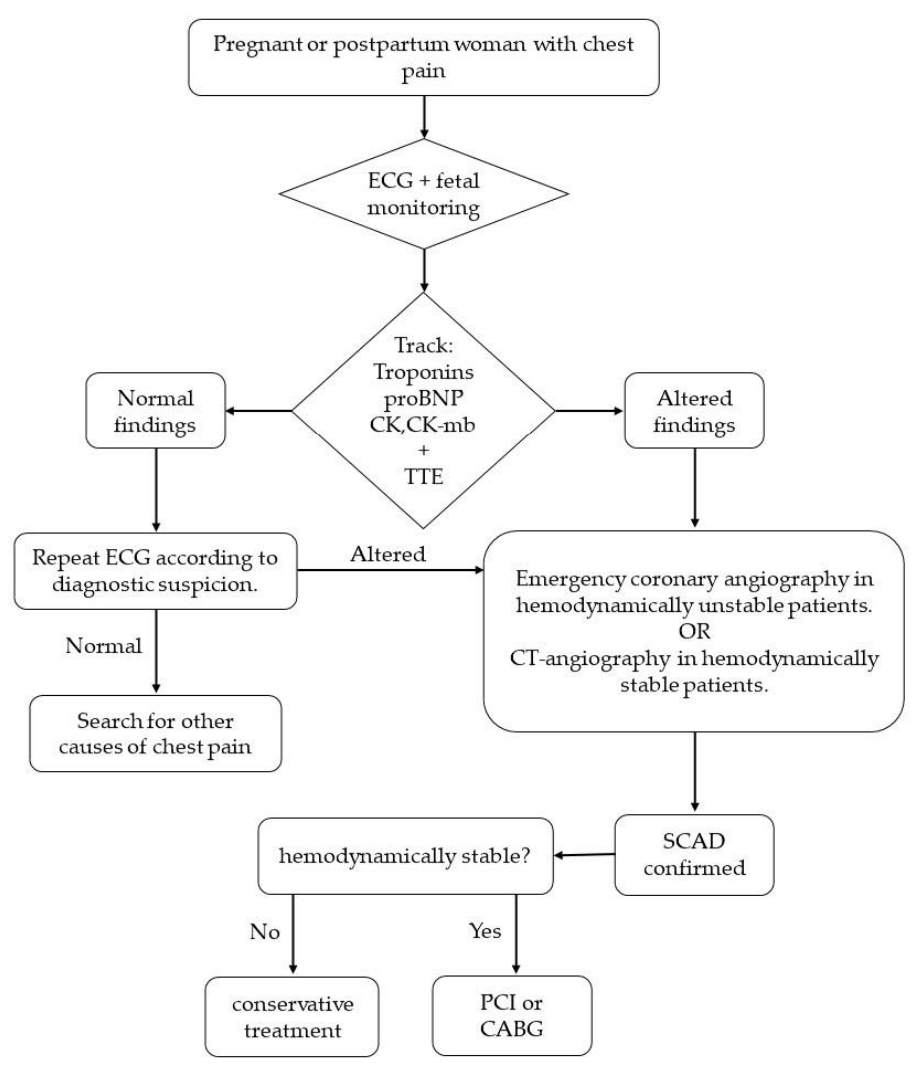
Figure 2. Suggested protocol for the diagnosis and treatment of SCAD. ECG: electrocardiogram; TTE: transthoracic echocardiogram; PCI: percutaneous coronary intervention; CABG: coronary artery bypass graft.